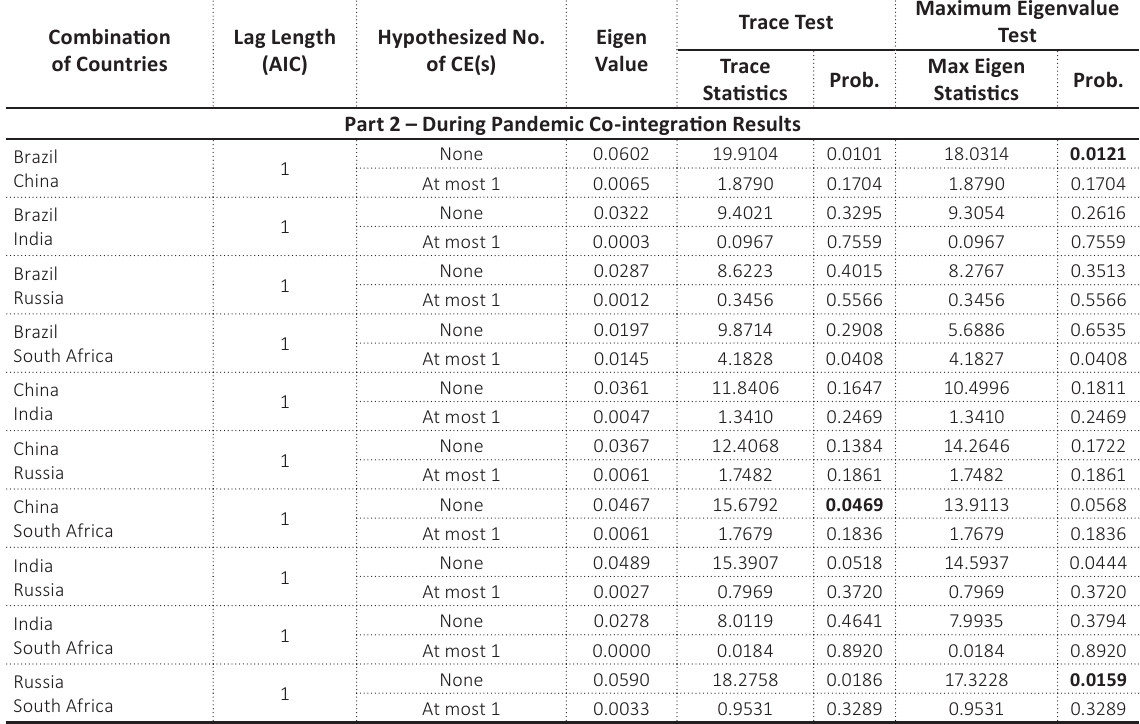
Table 4 (cont.). Johansen’s co-integration